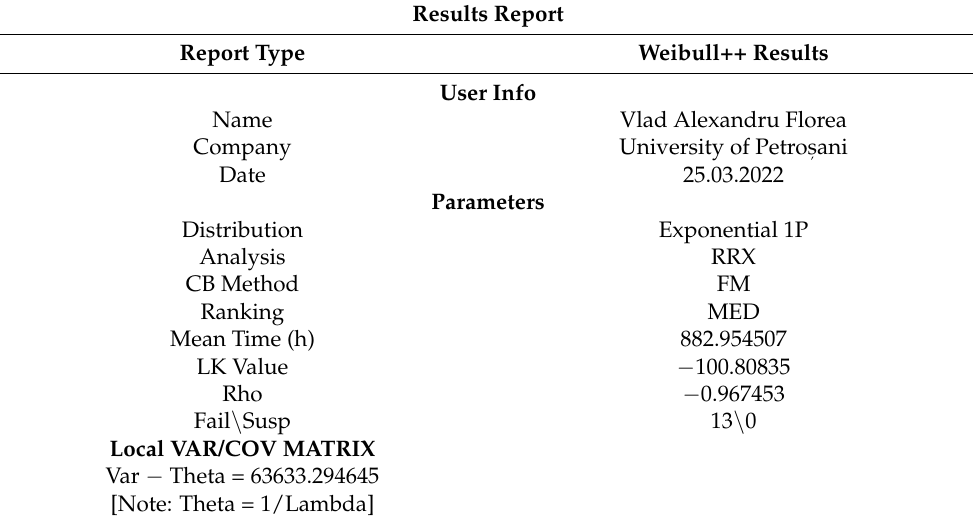
Table 3. Adopted exponential repartition law parameters for the captive